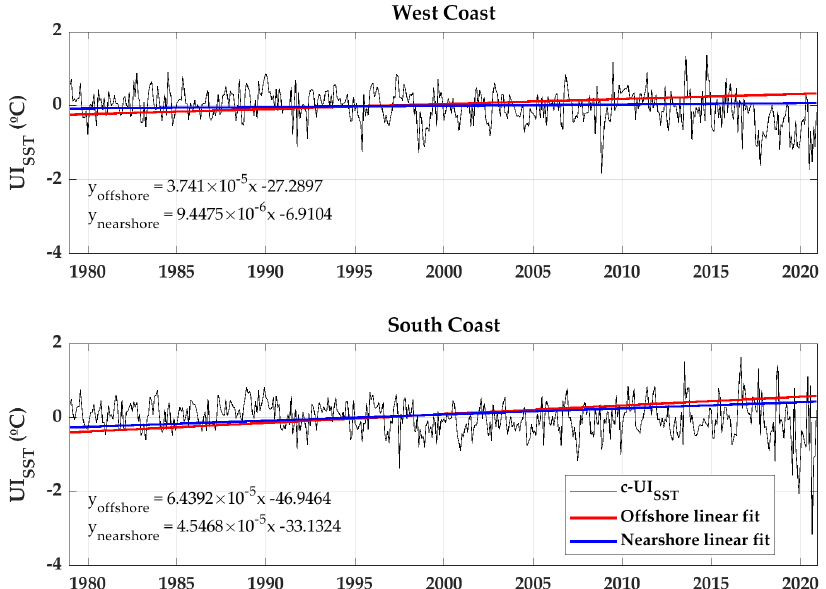
Figure 10. Annual evolution of UI SST (°C) on the Portuguese west coast and south coasts over the period 1979–2020, considering climatological normals of the nearshore and offshore spatially averaged temporal series. The blue and red lines represent simple linear fits of the nearshore and offshore spatial averages, respectively.